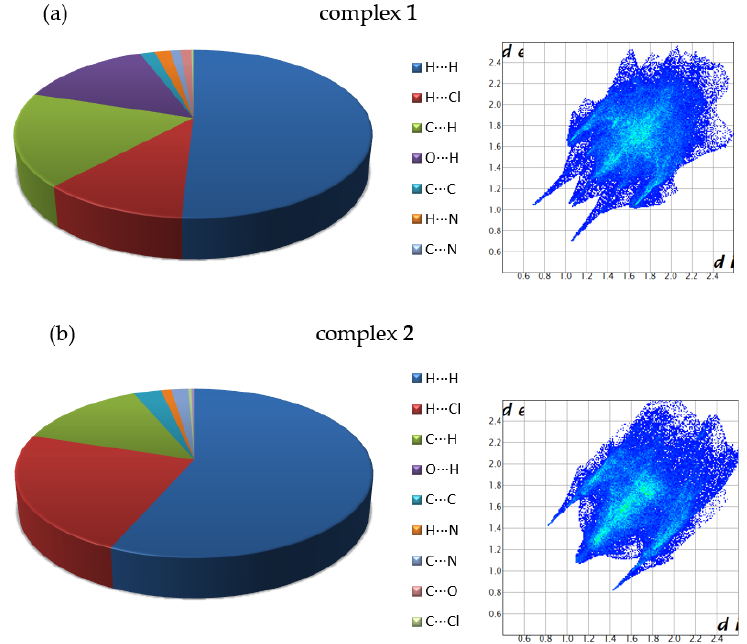
Figure 4. The 2D fingerprint plots of all the intermolecular interactions for complexes 1 ( a ) and 2 ( b ) with percentage of interaction.